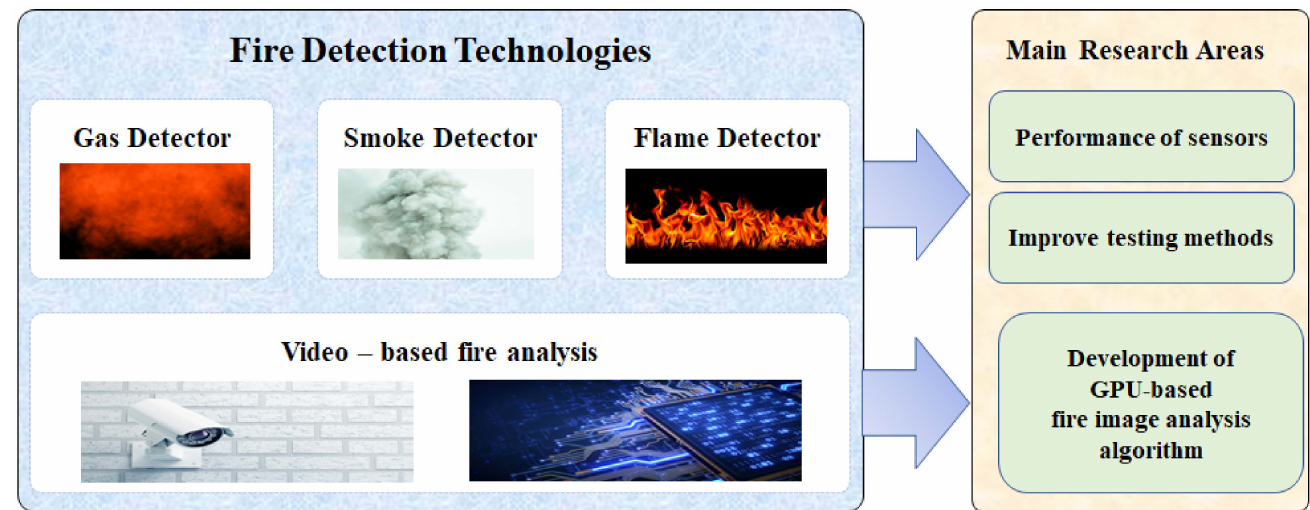
Figure 7. Prevention of Fires by Fire and Gas